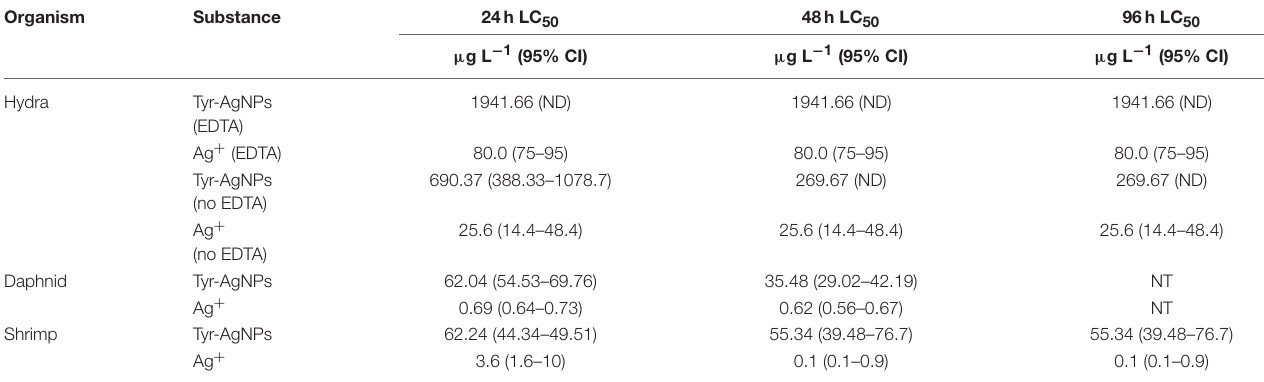
TABLE 3 | Hydra vulgaris, Daphnia carinata and Paratya australiensis lethality (LC 50 ) for tyr-AgNPs and Ag + ( ± 95% confidence interval, n = 3) (CI, Confidence interval; ND, Not defined; NT, Not tested).